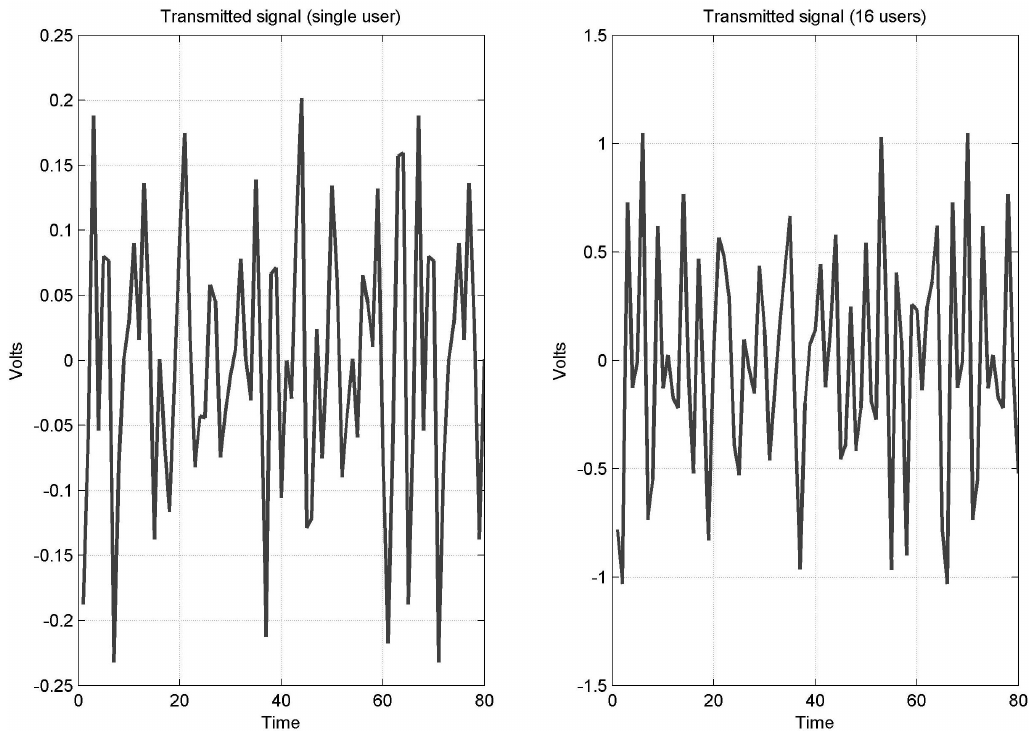
Figure 8. Transmitted signal of suggested DWT-MC-CDMA